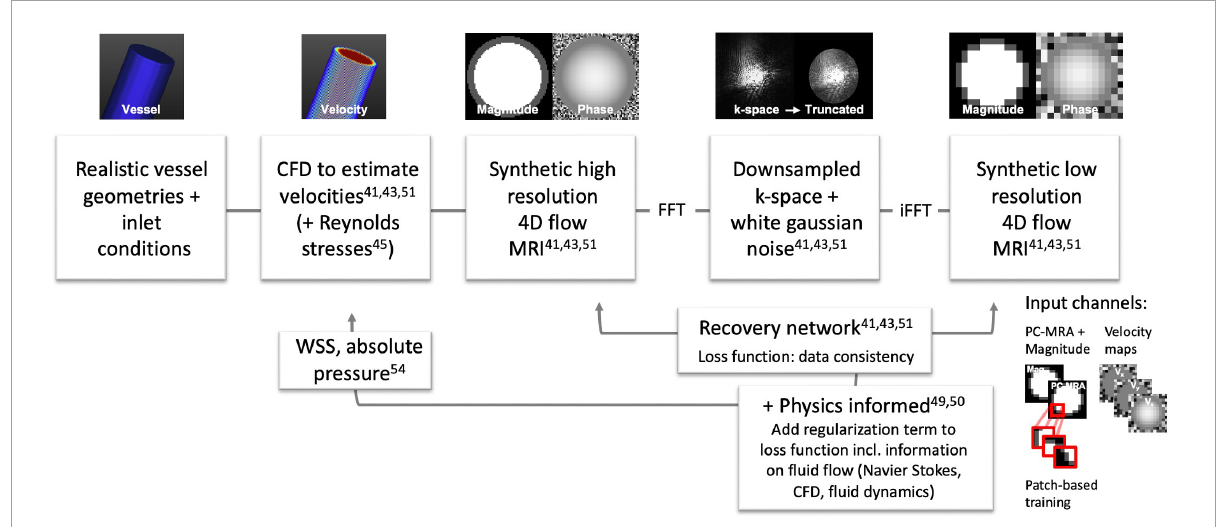
FIGURE2 Overview of frameworks for 4D flow MRI super-resolution training and data assimilation for 4D flow MRI and CFD data: Ferdian et al. (aortic simulation) (41), Rutkowski et al. (cerebrovascular simulations) (43), Kissas et al. (49), Fathi et al. (50), Dirix et al. (45), Ferdian et al. (54). Exemplary data in this figure was created with GTFlow (Gyrotools, Zürich,